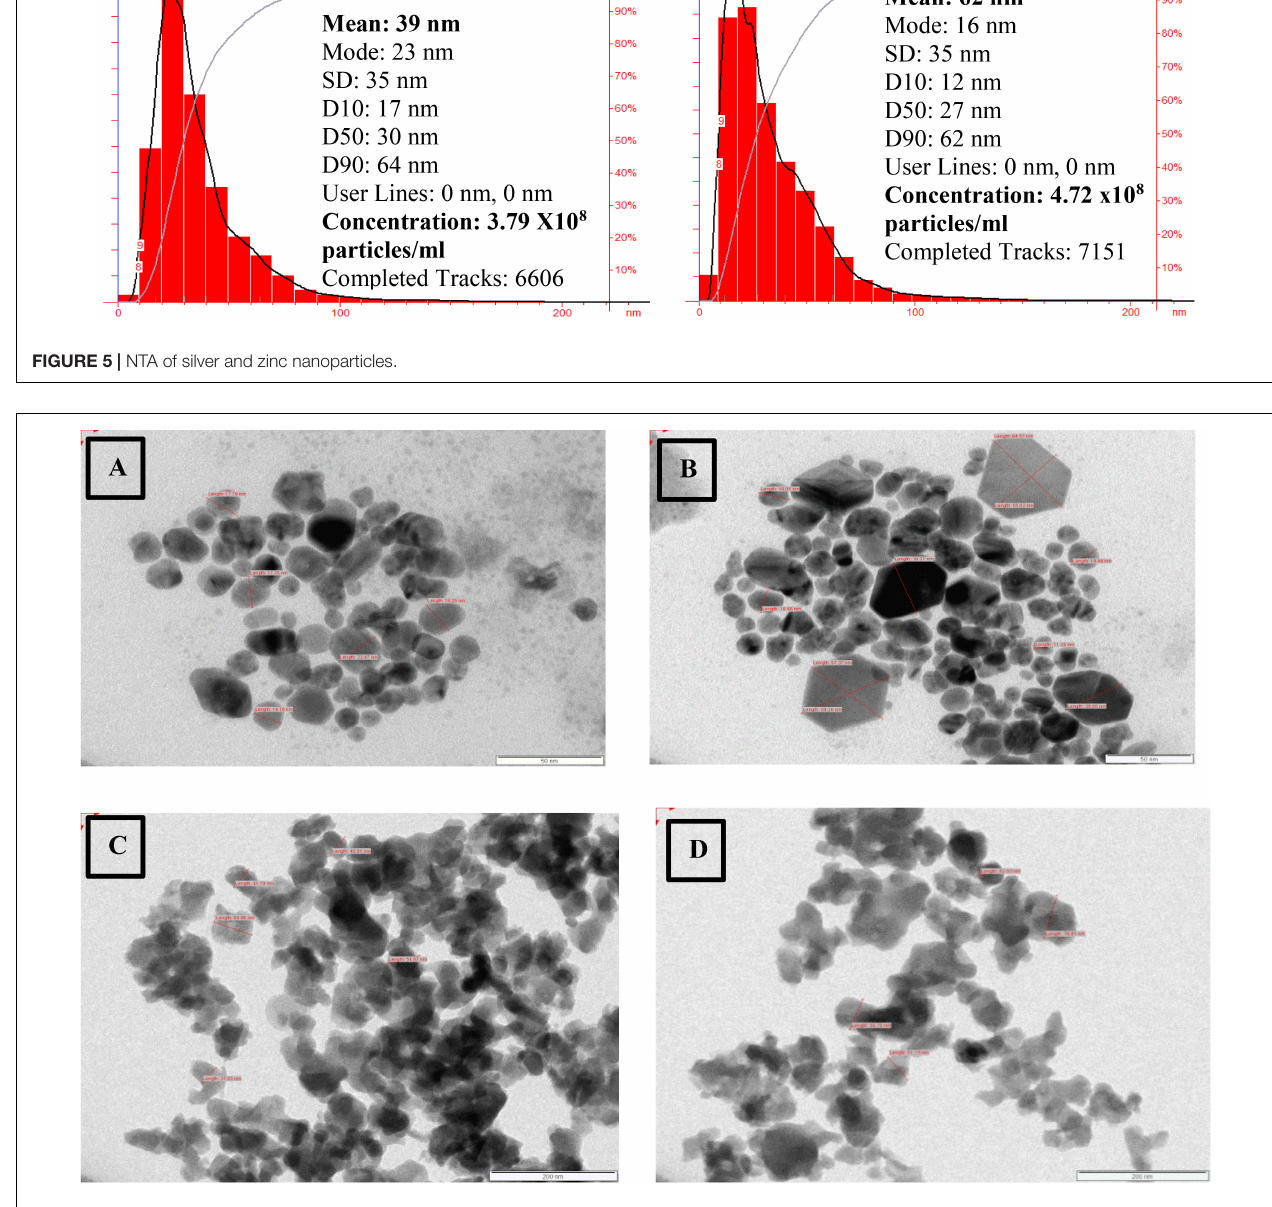
FIGURE 6 | TEM of silver nanoparticles (A,B) and zinc nanoparticles (C,D)